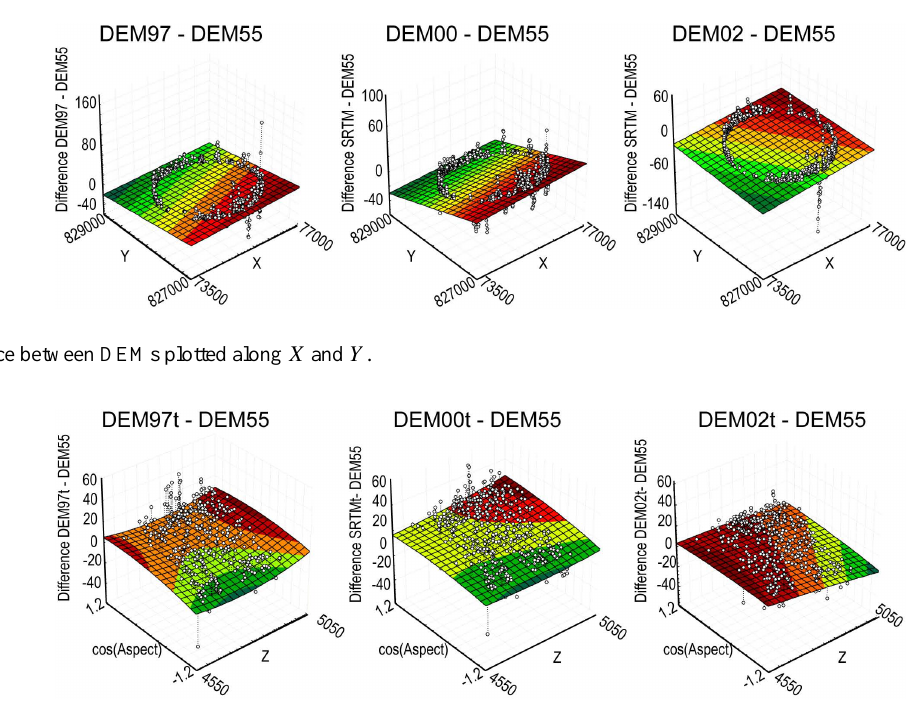
Fig. 4. Difference on rocky areas versus elevation and aspect for ASTER 2002.